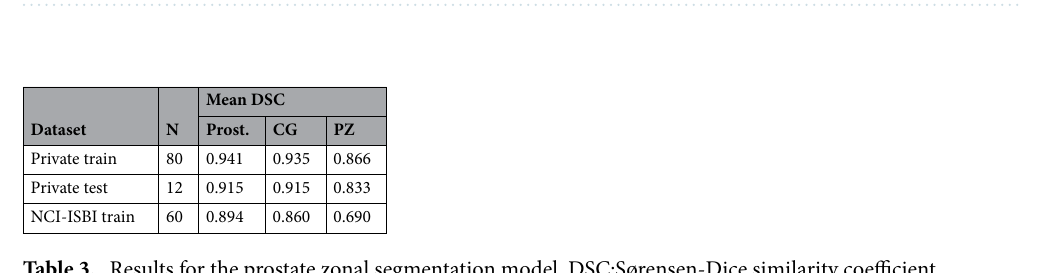
Table 2. Area under the ROC curve after dropping one (or several) particular sequences (i.e.: setting the value to 0) in test time for the Gleason Grade Group ≥ 2 significance criterion.